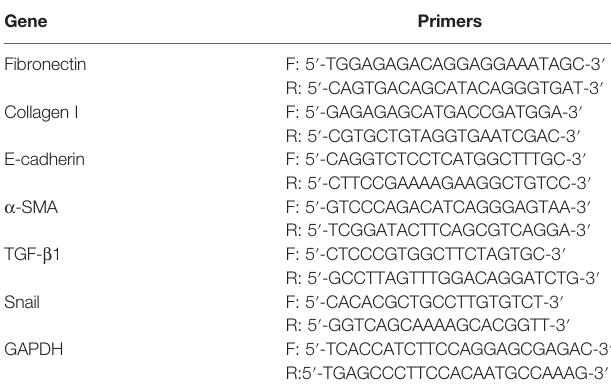
TABLE 1 | Primers sequences used for